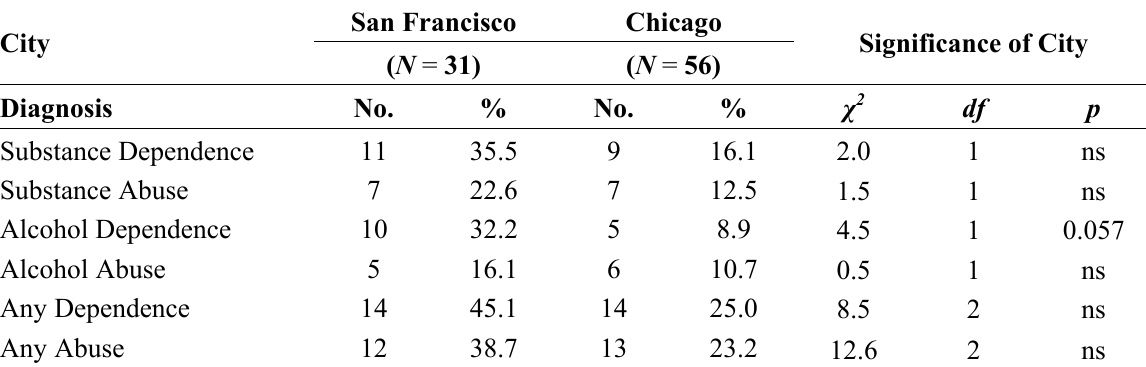
Table 3. M.I.N.I. diagnoses of substance-related disorders.